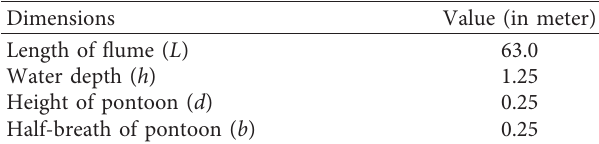
Table 2: Dimensions of the considered flume and heaving pontoon.